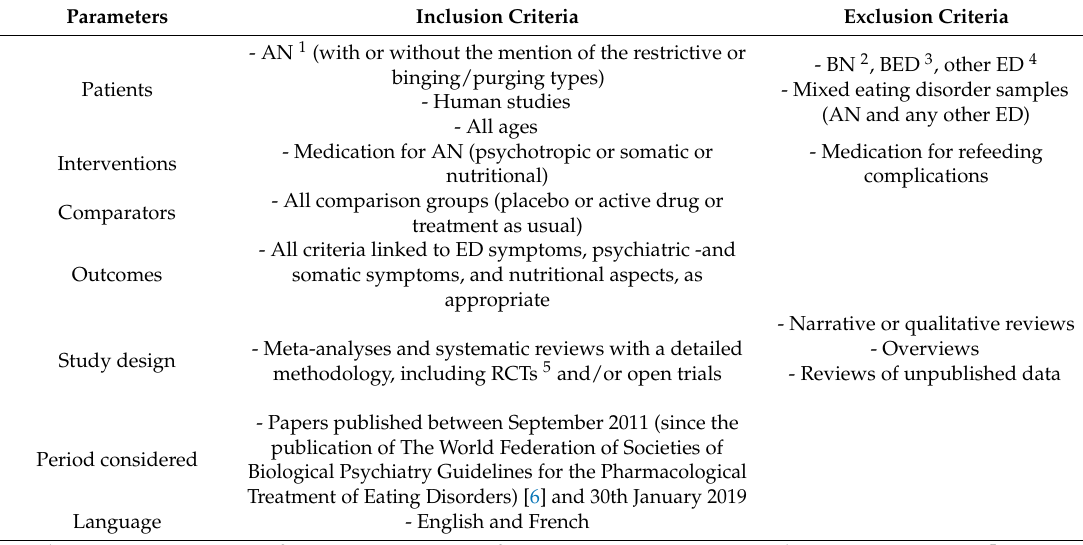
Table 2. Inclusion and exclusion criteria for the systematic overview of systematic reviews, meta- analyses and selected trials (Population Intervention Control Outcome and Study design (PICOS) criteria and other